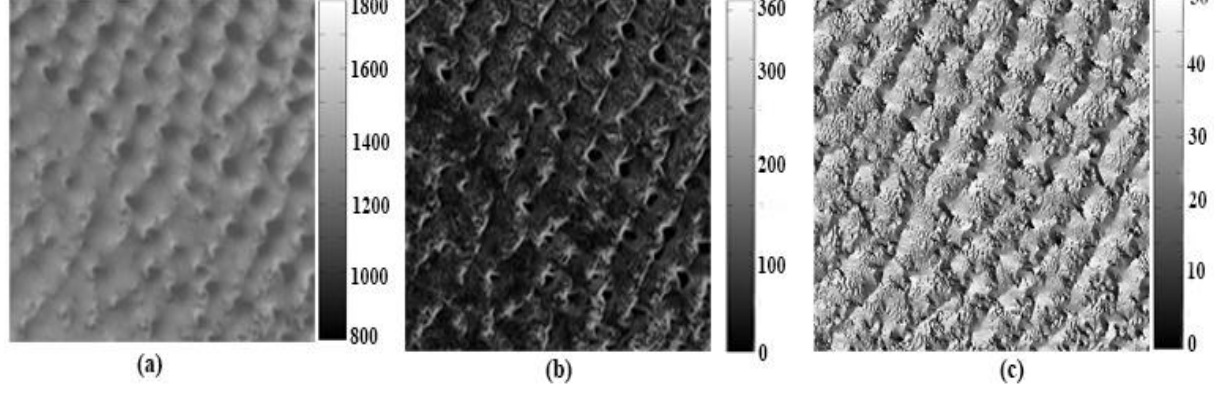
Figure 2. DEM, slope and aspect extracted from ZY-3/TLC. ( a ) DEM. ( b ) Aspect. ( c )